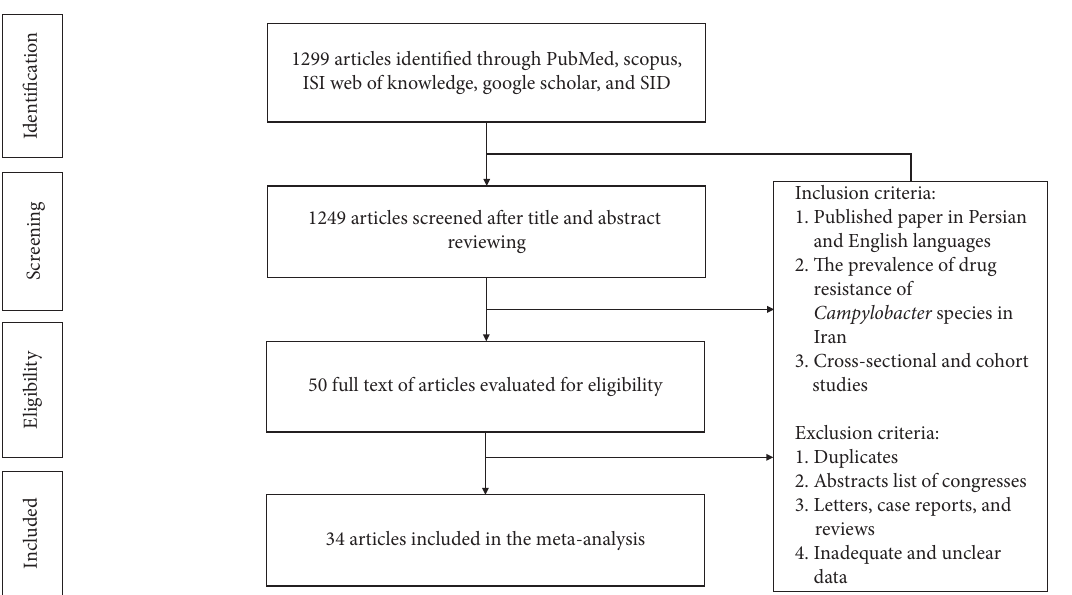
Figure 1: A summary of the study selection Table 2. The prevalence of resistance of C. coli to different